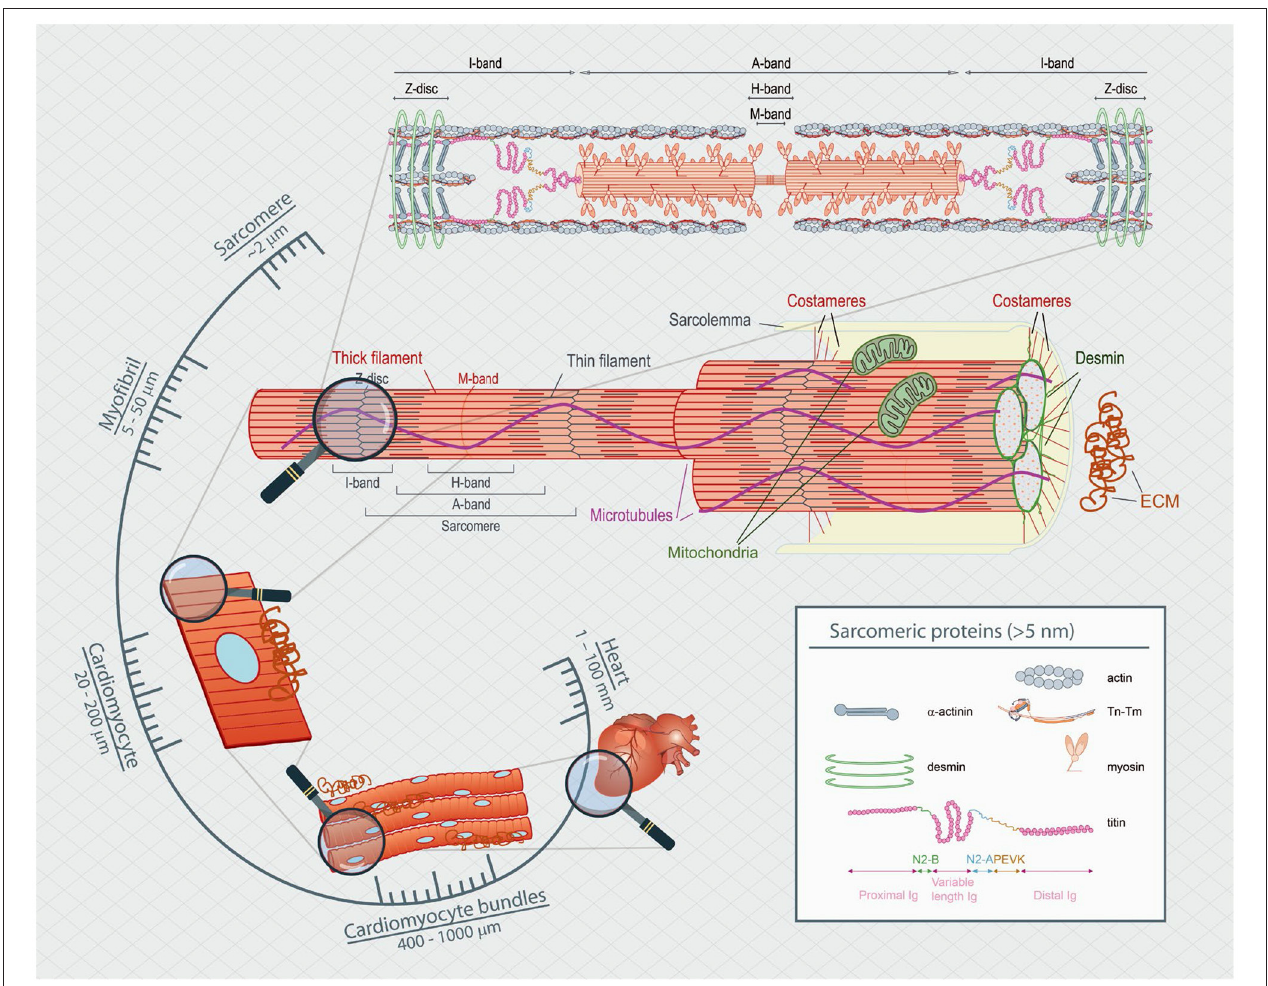
FIGURE 1 | Spatial scaling of the heart’s functional components. The heart is composed of many layers of complexity, which span many orders of magnitude. From the nanometer length range of actin-myosin interactions to the micrometer level of the sarcomeric apparatus and up to the hundreds of micrometer of single cells, passing through multicellular sheets of bundles of cells measured in the millimeter length that make up the millimeter rodent animal